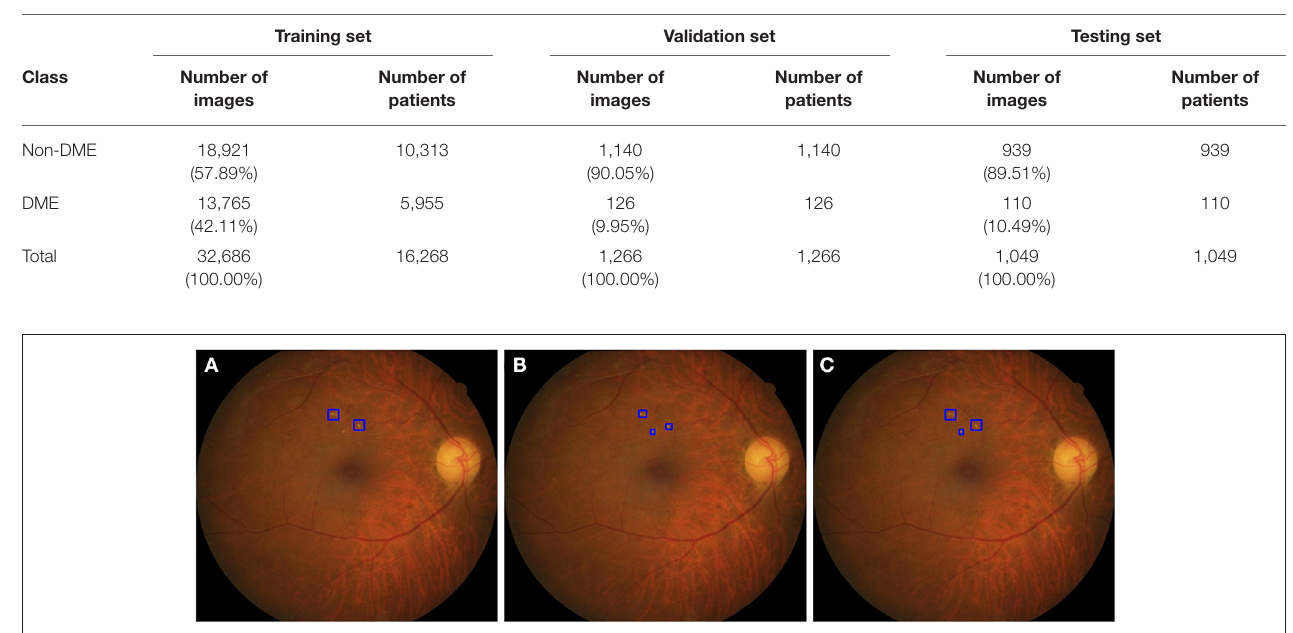
FIGURE 2 | The strategy to obtain a ground truth image. (A) The two boxes were annotated by first ophthalmologist. (B) The three boxes were annotated by second ophthalmologist. In step 1, the IoU of the top two bounding boxes in (A,B) were larger than 0.15, then two larger areas were taken as the GT. In step 2, the IoU of bottom boxes in (A,B) were < 0.15, the area annotated by the second ophthalmologist was retained as the GT. After step 1 and 2, we obtained a GT image (C) .